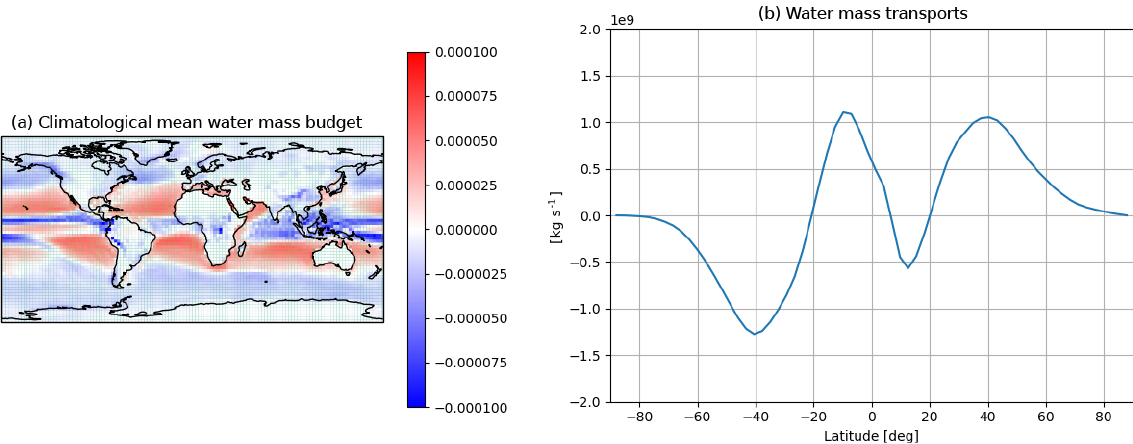
Figure 4. (a) Climatological annual mean water mass fluxes (kgm − 2 s − 1 ) and (b) annual mean northward meridional water mass transport (kgs − 1 ) for a 20-year pre-industrial CanESM2 model